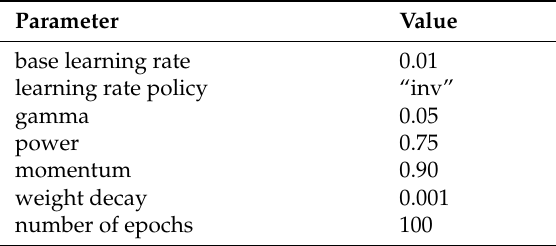
Table 3. Training